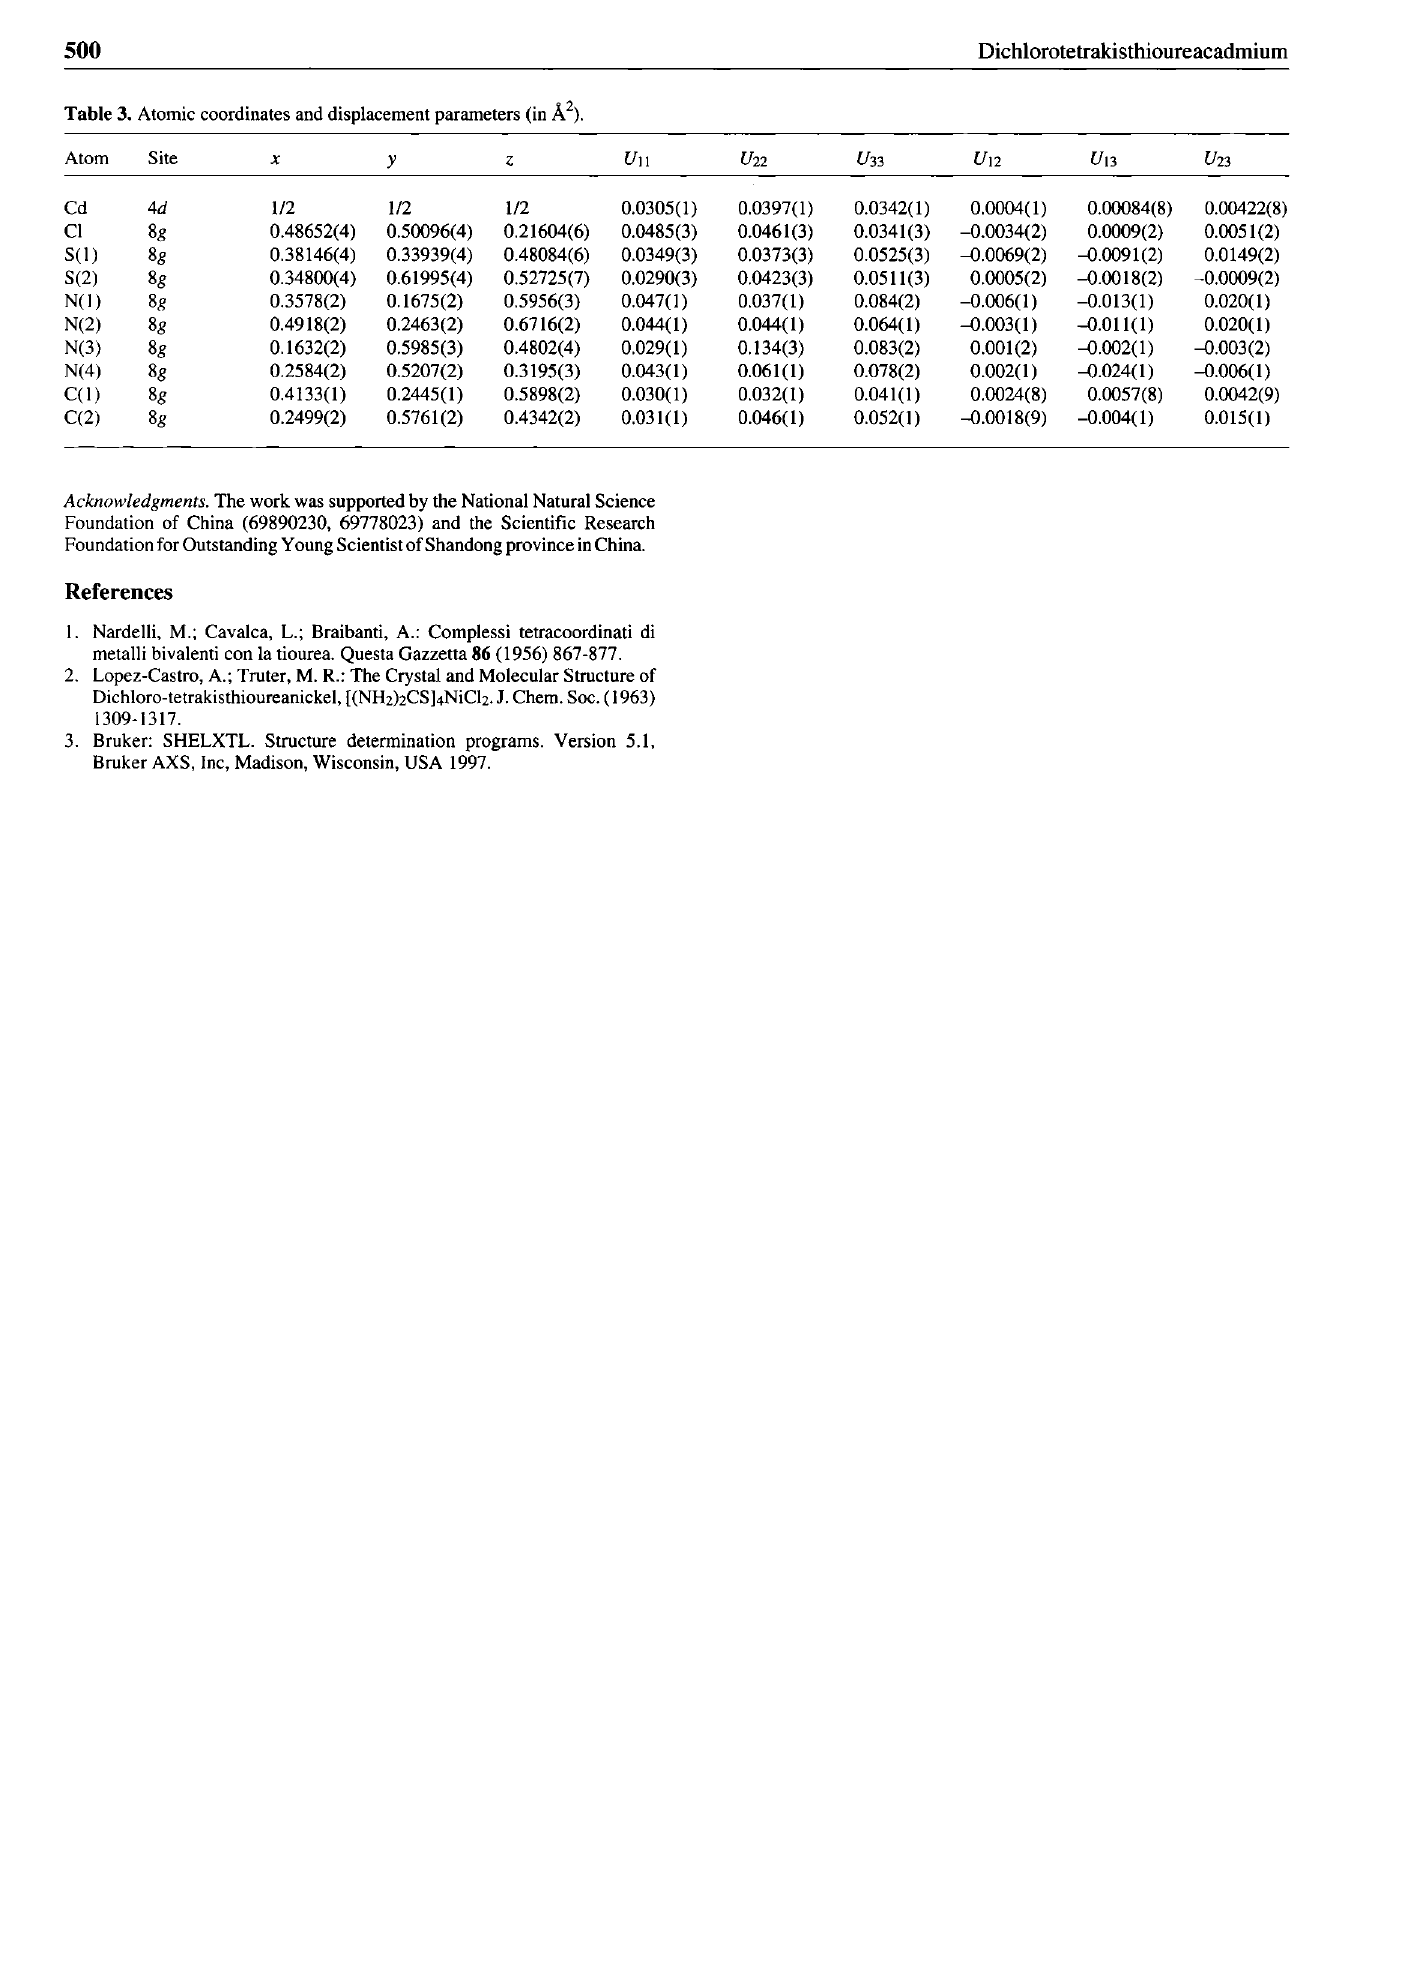
Table 3. Atomic coordinates and displacement parameters (in À 2